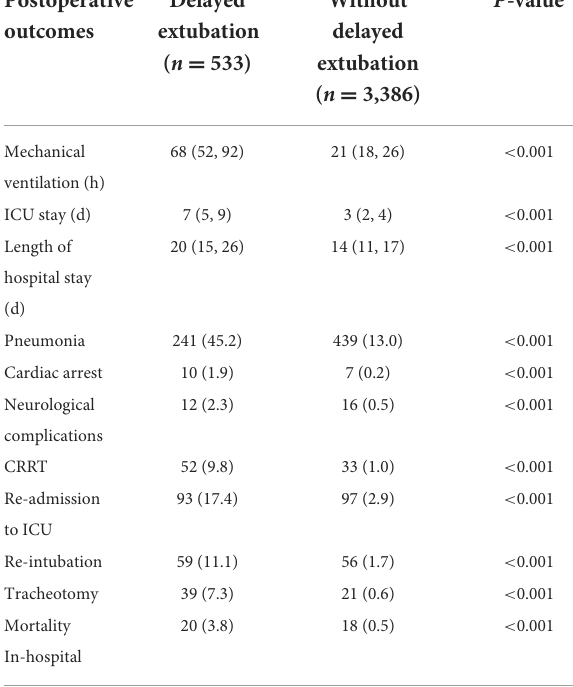
TABLE 4 Comparison of clinical outcomes in patients with and without delayed